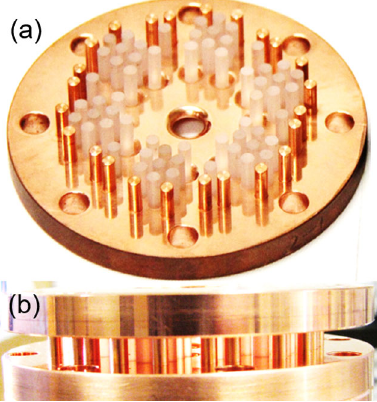
FIG. 15. (a) The rod plate with rods inserted, and (b) the central HPBG cell assembled for the S 21 measurement.